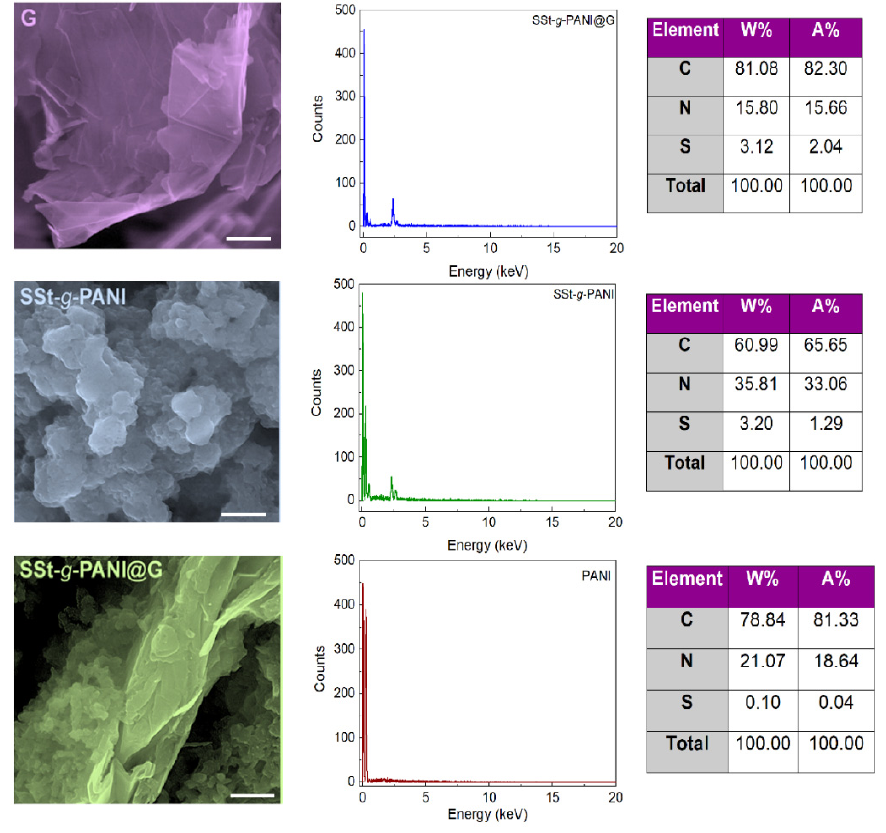
Figure 4. The FE-SEM images (scale 500 nm) of graphene (G), sulfonated starch- graft -polyaniline (SSt- g -PANI), and the sulfonated starch- graft -polyaniline copolymer@graphene (SSt-g-PANI@G) nanocomposite. EDX spectra and tabulated data of PANI, SSt- g -PANI, and the SSt- g -PANI@G nanocomposite. Table 1. The result of elemental analysis (CHNSO) of sulfonated starch (SSt), sulfonated starch- graft -polyaniline (SSt- g -PANI), and the sulfonated starch- graft -polyaniline@graphene (SSt- g - PANI@G) nanocomposite.